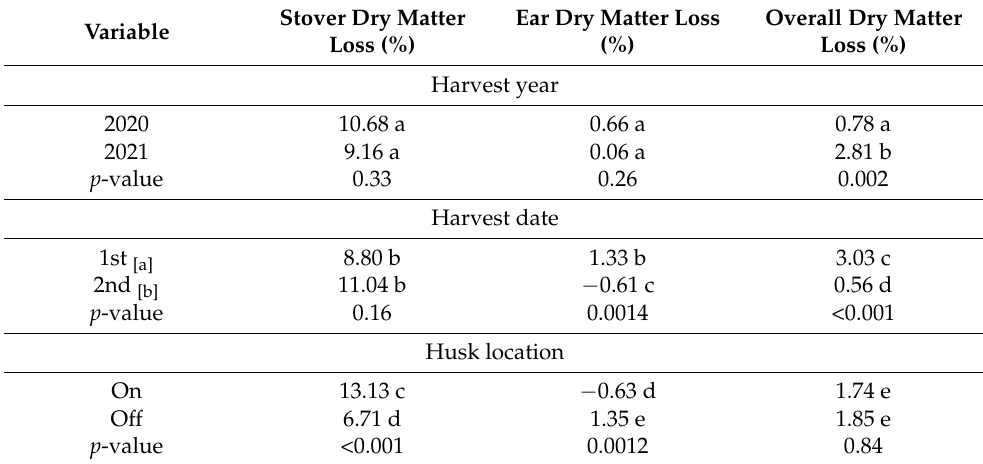
Table 3. Measured dry matter losses for stover, ear, and the overall treatment.